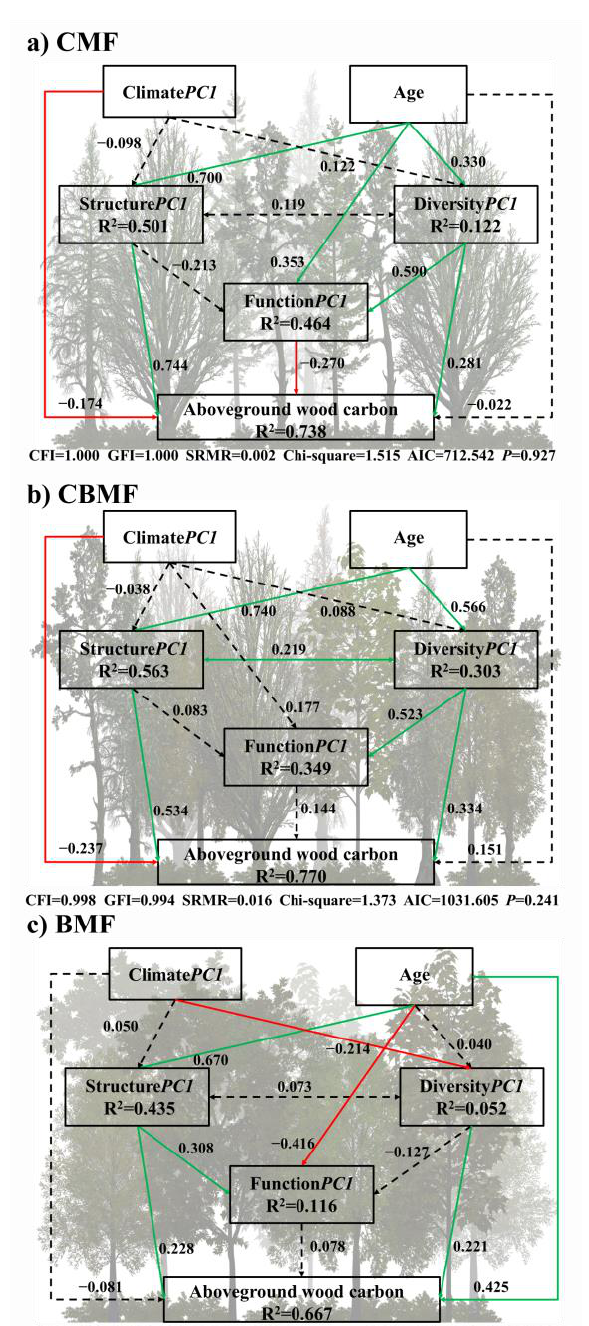
Figure 6. Structural equation models for testing the direct effects of climate and stand age versus indirect effects mediated by stand structure, stand diversity, and stand function on aboveground wood carbon with the change in forest types. CMF, CBMF, and BMF represent coniferous mixed forests, coniferous–broadleaf mixed forests, and broadleaf mixed forests, respectively. PC1 refers to the first principal component of the results of principal component analysis. Numerical values under each graph refer to comparative fit index (CFI), goodness-of-fit index (GFI), standardized root mean square residuals (SRMR), and Akaike information criteria (AIC). The dashed lines represent non- salient paths ( p > 0.05), while the solid lines represent significant paths ( p < 0.05). The standardized coefficients are marked (see Table S2 for statistics). Positive and negative pathways are shown in green and red colors, respectively. R 2 represents the proportion of explained